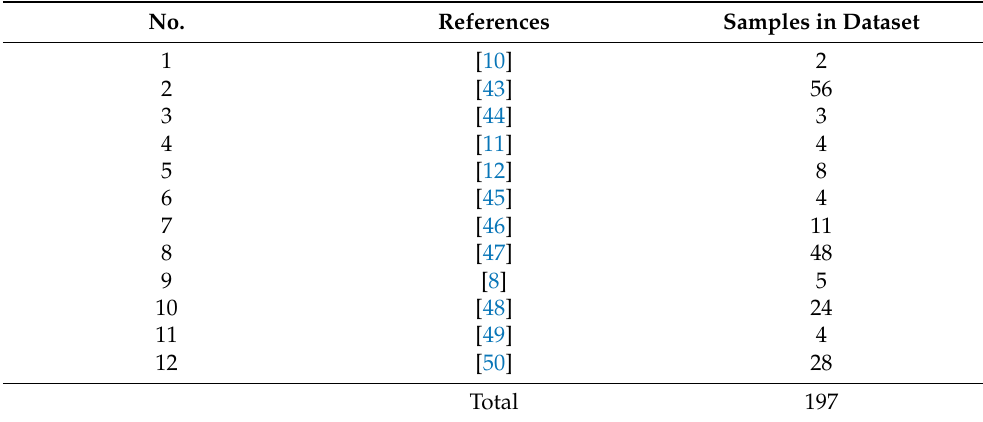
Table 2. Sources used for the database